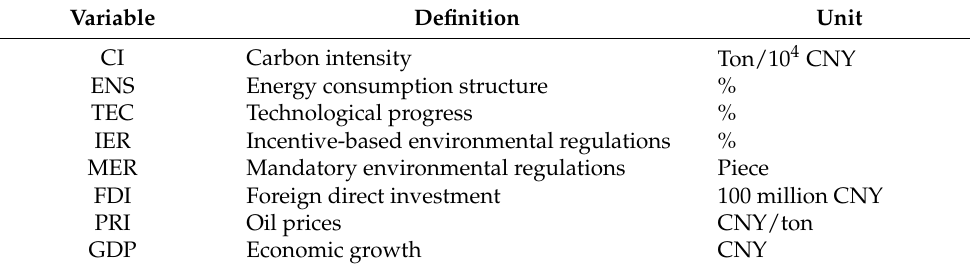
Table 1. Definition and unit of variables in this paper.